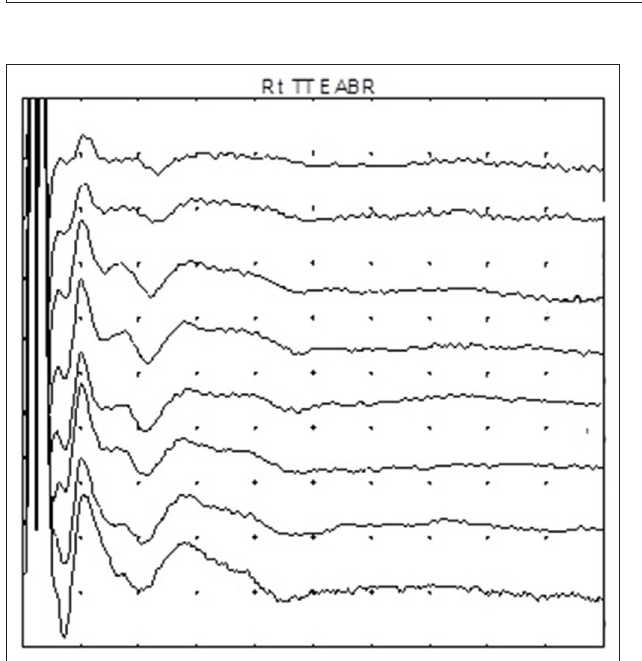
FIGURE 4 | The long coaxial cable which connects the electrodes to the preamplifier which can be sterilized for intraoperative recordings.